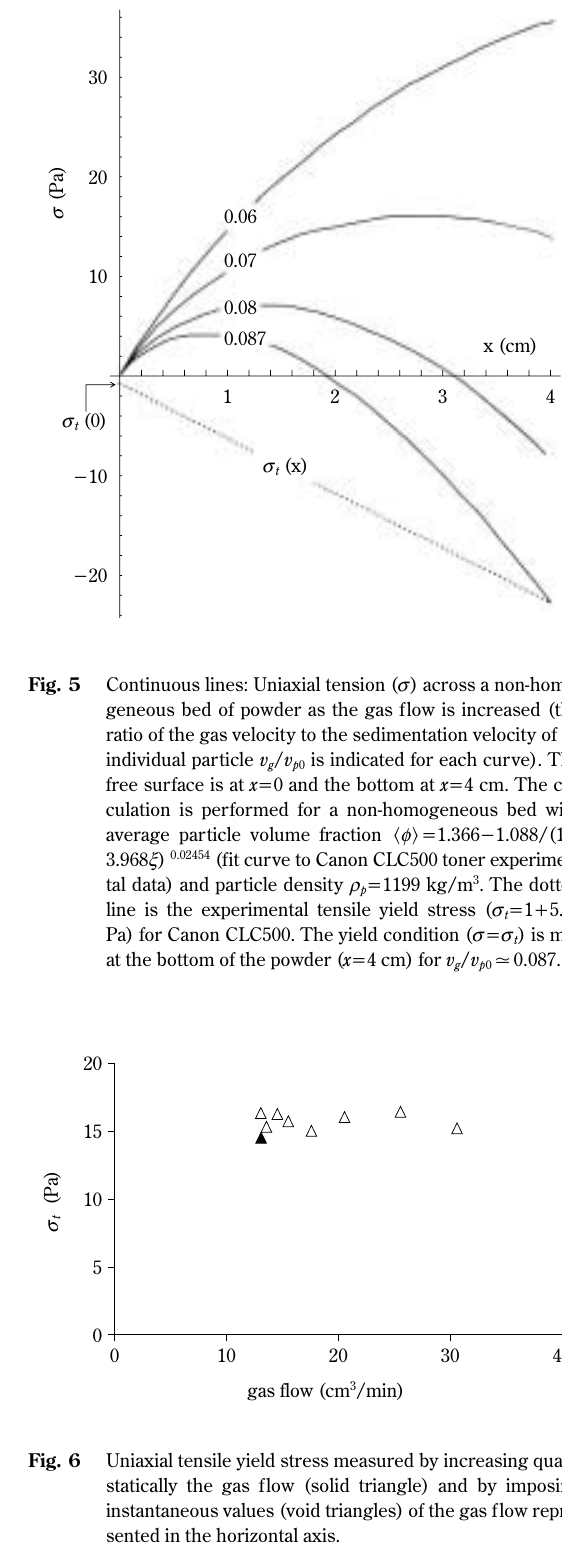
seen that the deviation between the results is within the experimental scatter ( (cid:10) 1 Pa).